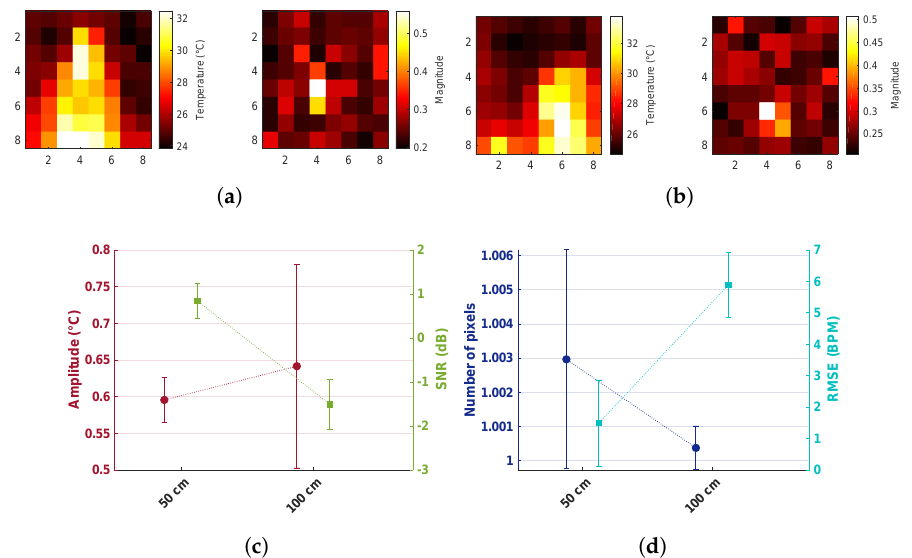
Figure 5. Respiration detection through shoulder motion: ( a , b ) the first figure shows a thermal image, and the second one shows the spectrum peak magnitude distribution of a subject seated and lying respectively at 50 cm of distance; ( c , d ) overview of the differences in amplitude, SNR, number of pixels, and RMSE when data were collected from a seated subject at 50 and 100 cm.